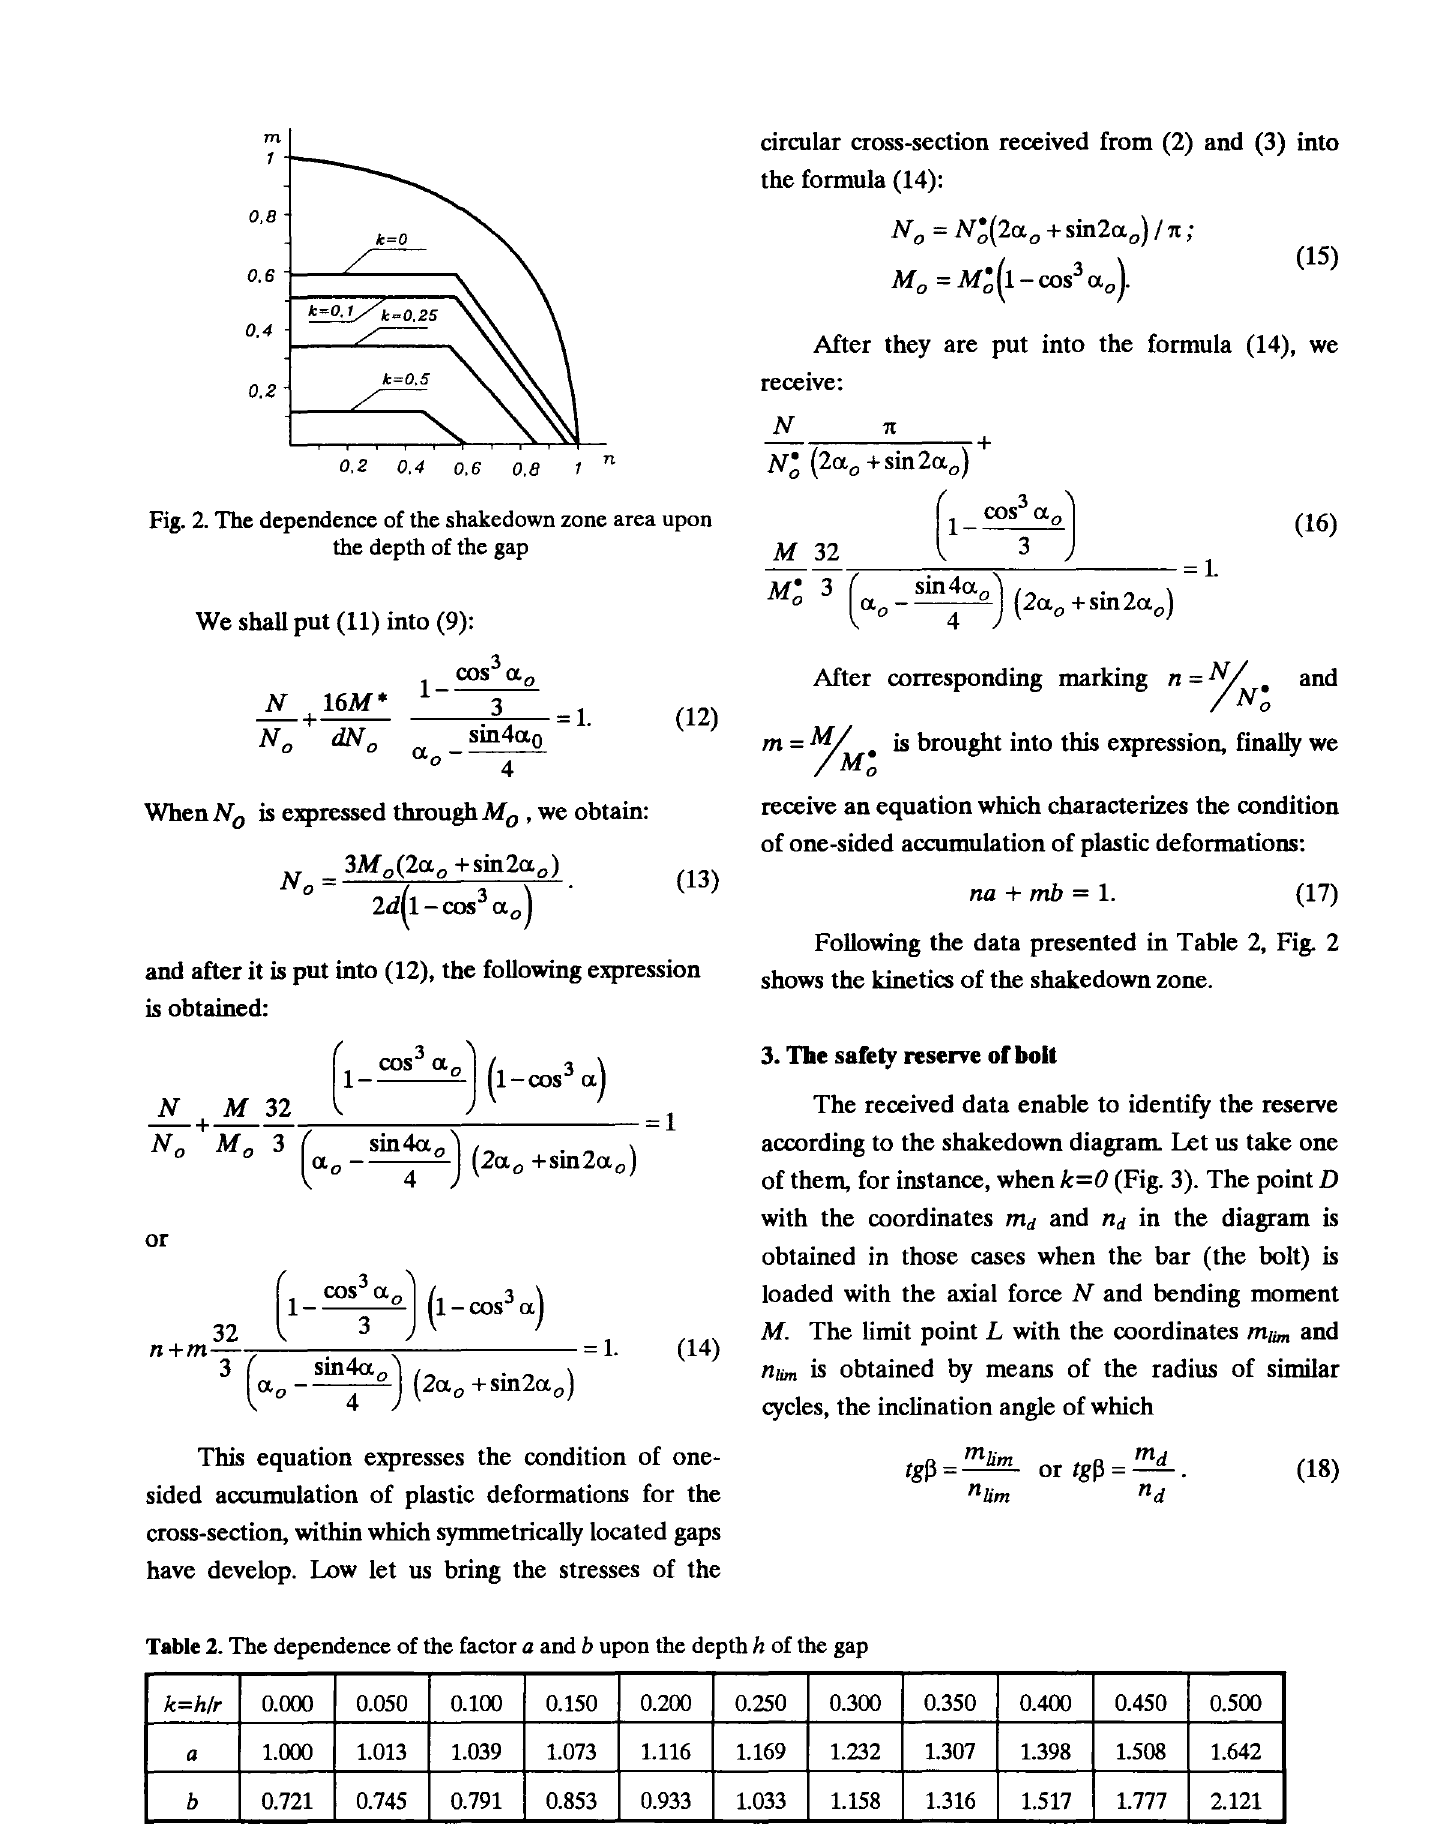
Table 2. The dependence of the factor a and b upon the depth h of the gap k=h/r